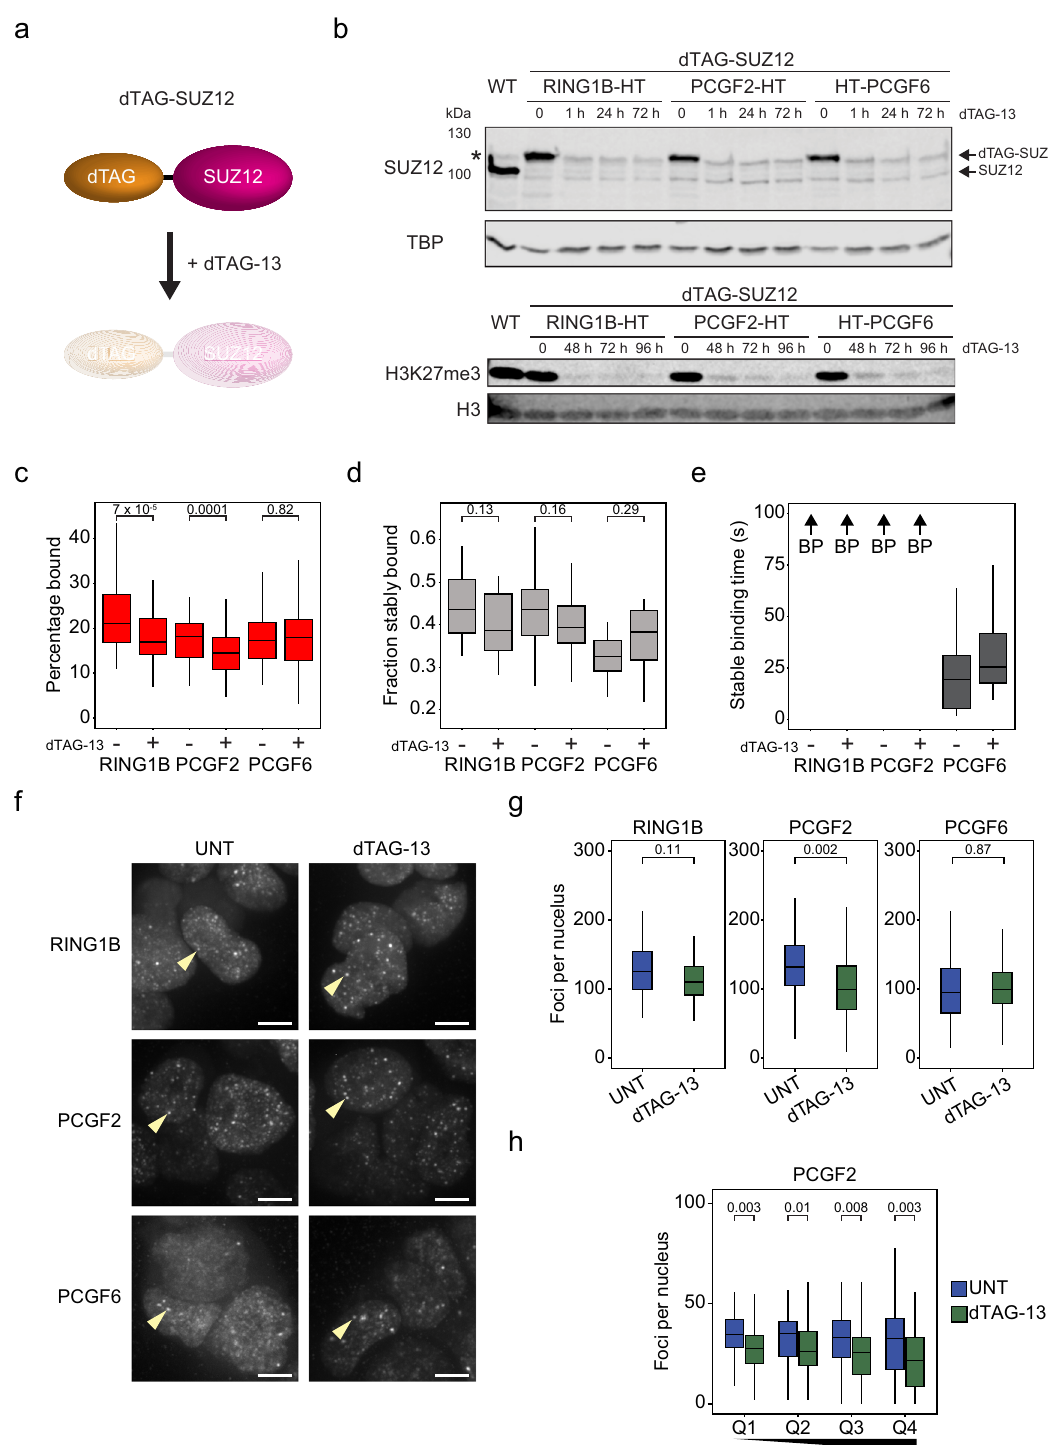
heterodimerises with RING1B, forming a RING-RING domain dimer that is responsible for the ubiquitin ligase activity of the complex. In contrast, the C-terminus of PCGF1 contains a RAWUL domain which interacts with the PCGF1-PRC1 complex speci fi c proteins KDM2B and BCOR/BCORL1 34,38,48,107 . In order to determine which of these domains and their interactions might explain the chromatin binding behaviour of PCGF1 we generated cell lines stably expressing exogenous HaloTag-PCGF1 fusion